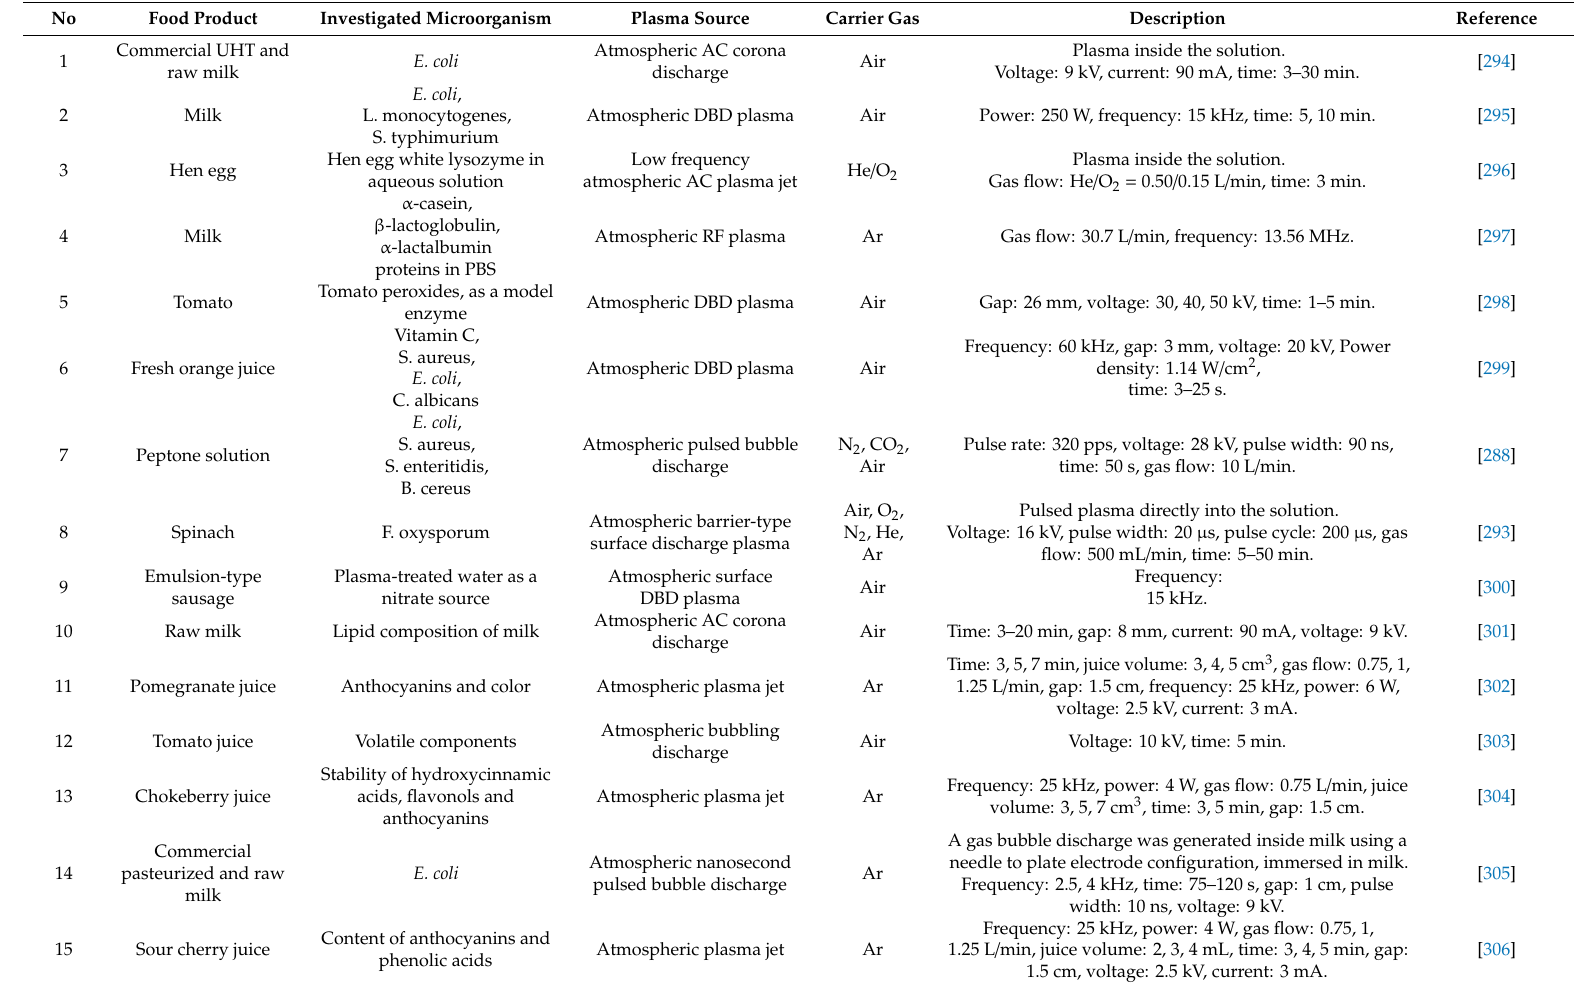
Table 8. An overview of studies on the impact of non-thermal plasma on liquid food